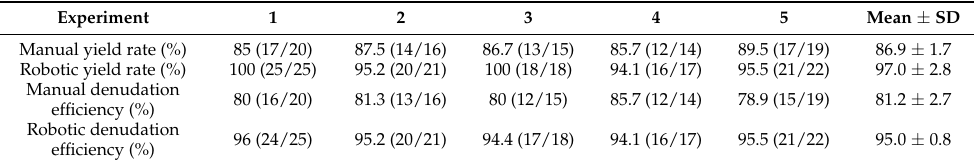
Table 1. Experimental results of mouse oocyte